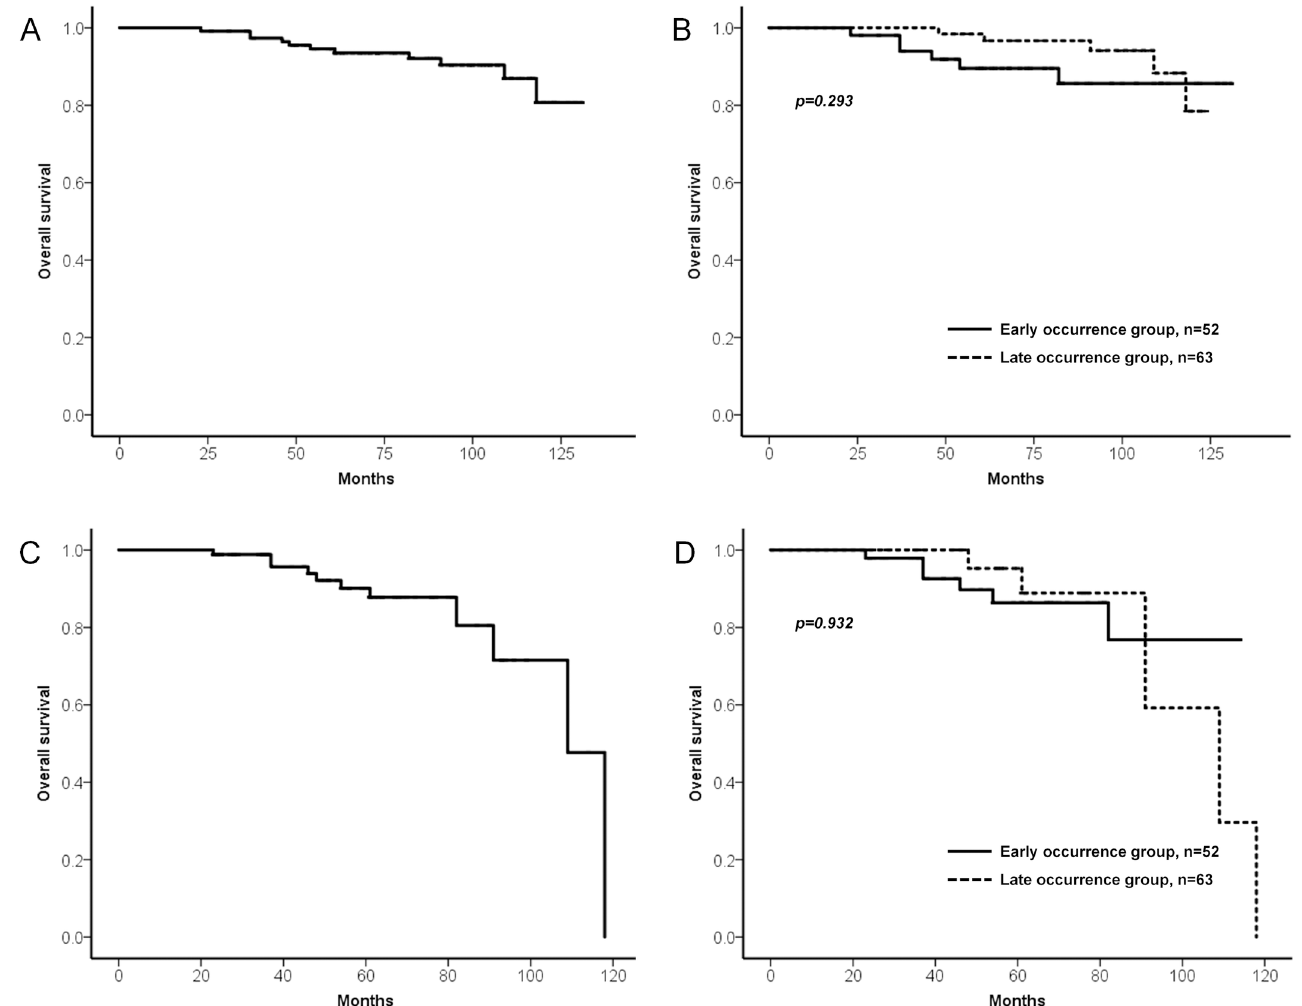
Fig 4. Survival analysis of the patients with MGT after ESD. (A) Kaplan-Meier survival curve for overall survival in the wholepatient group. (B) Kaplan-Meier survival curves for overall survival in early occurrence group and late occurrence group. (C) Kaplan-Meier survival curve for overall survival after diagnosisof MGT in the wholepatient group. (D) Kaplan-Meier survival curves for overall survival after diagnosisof MGT in early occurrence group and late occurrence group.